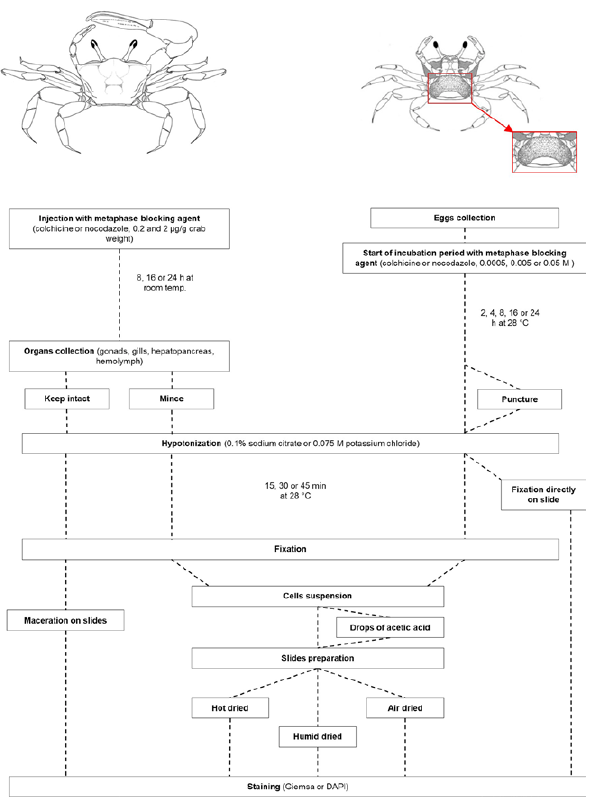
Figure 1. Schematic representation of the experimental plan. Crabs representations modified from